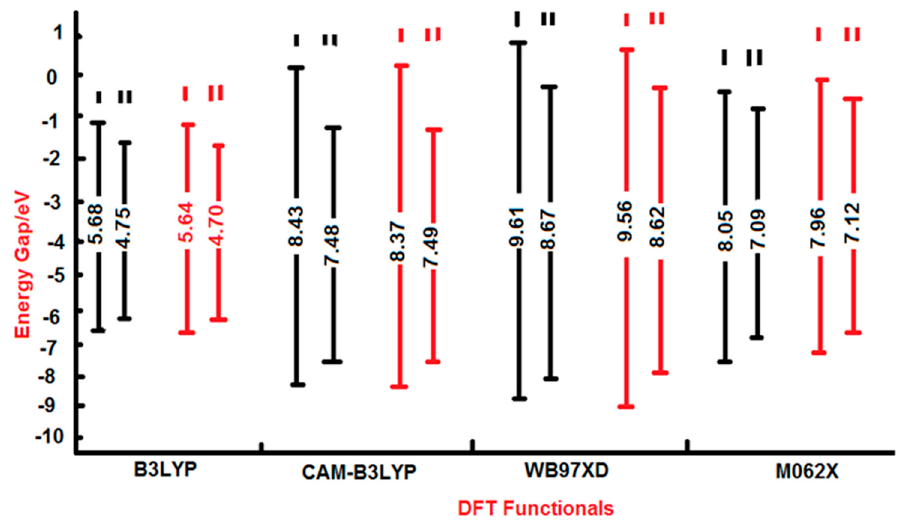
Figure 5. Schematic molecular orbital energy level diagram for the energy gaps of 2-HPY (I); and 2-PY (II) tautomers. It has been drawn using data from B3LYP, CAM-B3LYP, M062X and wB97XD functionals with 6-311++G** (black lines); and aug-cc-pvdz (red lines) basis sets.